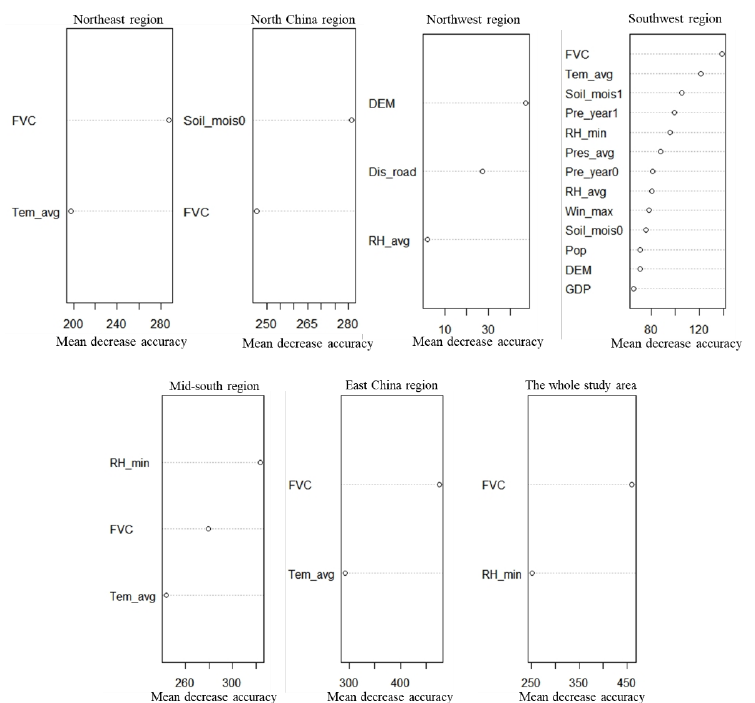
Figure 3. Importance rankings of the forest fire driving factors according to the mean decrease accuracy in six geographical regions and the whole study area. The abbreviated variable names are the same as in Table